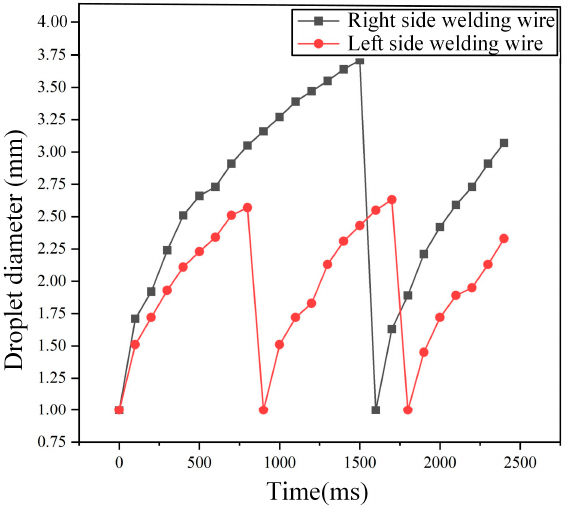
Figure 4. Changes in droplet size in the model of “free transfer + free transfer.”